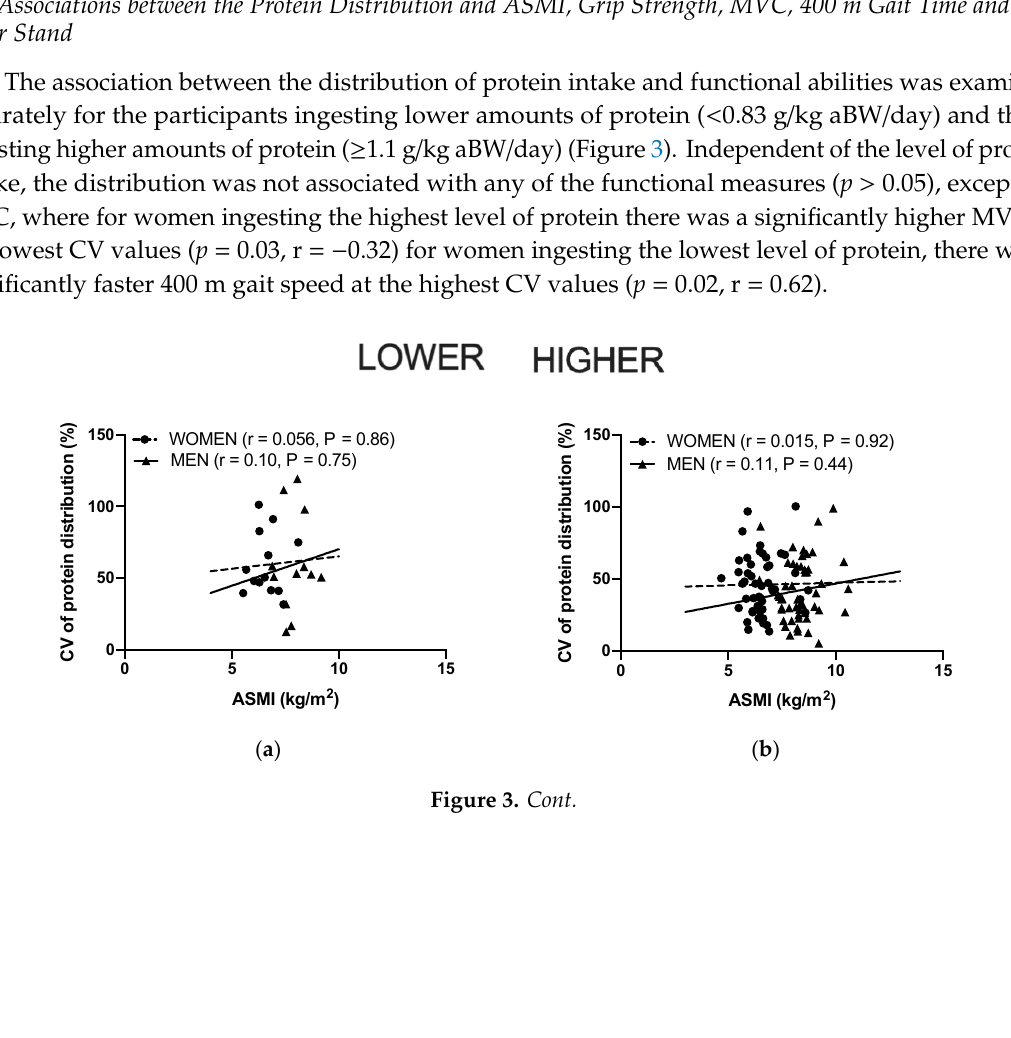
Figure 2. Appendicular Skeletal Muscle Index (ASMI) ( a ), grip strength ( b ), knee extension Maximal Voluntary isometric Contraction (MVC) ( c ), 400 m gait time ( d ), 30 s chair stand ( e ) divided into individuals with a protein intake of <0.83 g/kg aBW/day ( n = 25, 12 men and 13 women), ≥ 0.83–<1.1 g/kg aBW/day ( n = 61, 36 men and 25 women), ≥ 1.1 g/kg aBW/day ( n = 98, 50 men and 48 women ( n = 47 for MVC due to one missing value). Values are means with 95% CI. ** p < 0.01, *** p < 0.001, **** p < 0.0001, Turkey’s multiple comparison test (comparing between average daily protein intake levels and sexes). Significance was set at p < 0.05.